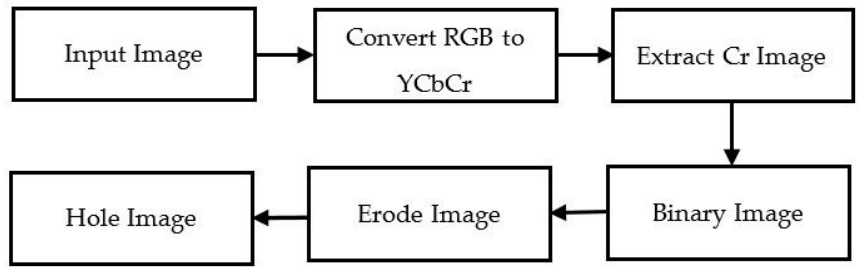
Figure 2. Block diagram of the YCbCr segmentation process.